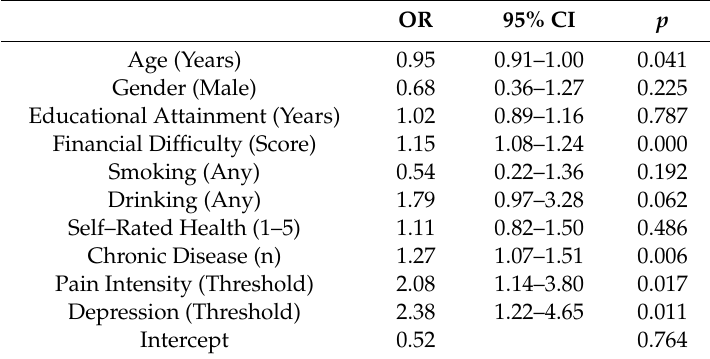
Table 3. Logistic regression on predictors of odds of possible clinical